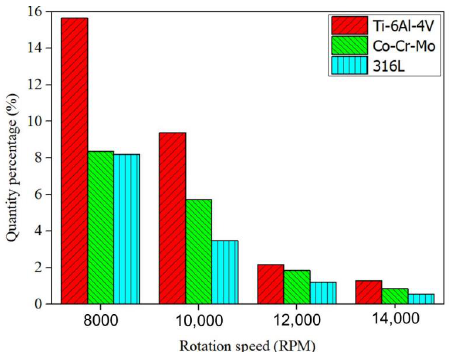
Figure 6. The 3D reconstructed CT of ( a ) Ti-6Al-4V, ( b ) Co-Cr-Mo, ( c ) 316L at 8000 RPM; as well as ( d ) Ti-6Al-4V, ( e ) Co-Cr-Mo, ( f ) 316-steel at 12,000 RPM.